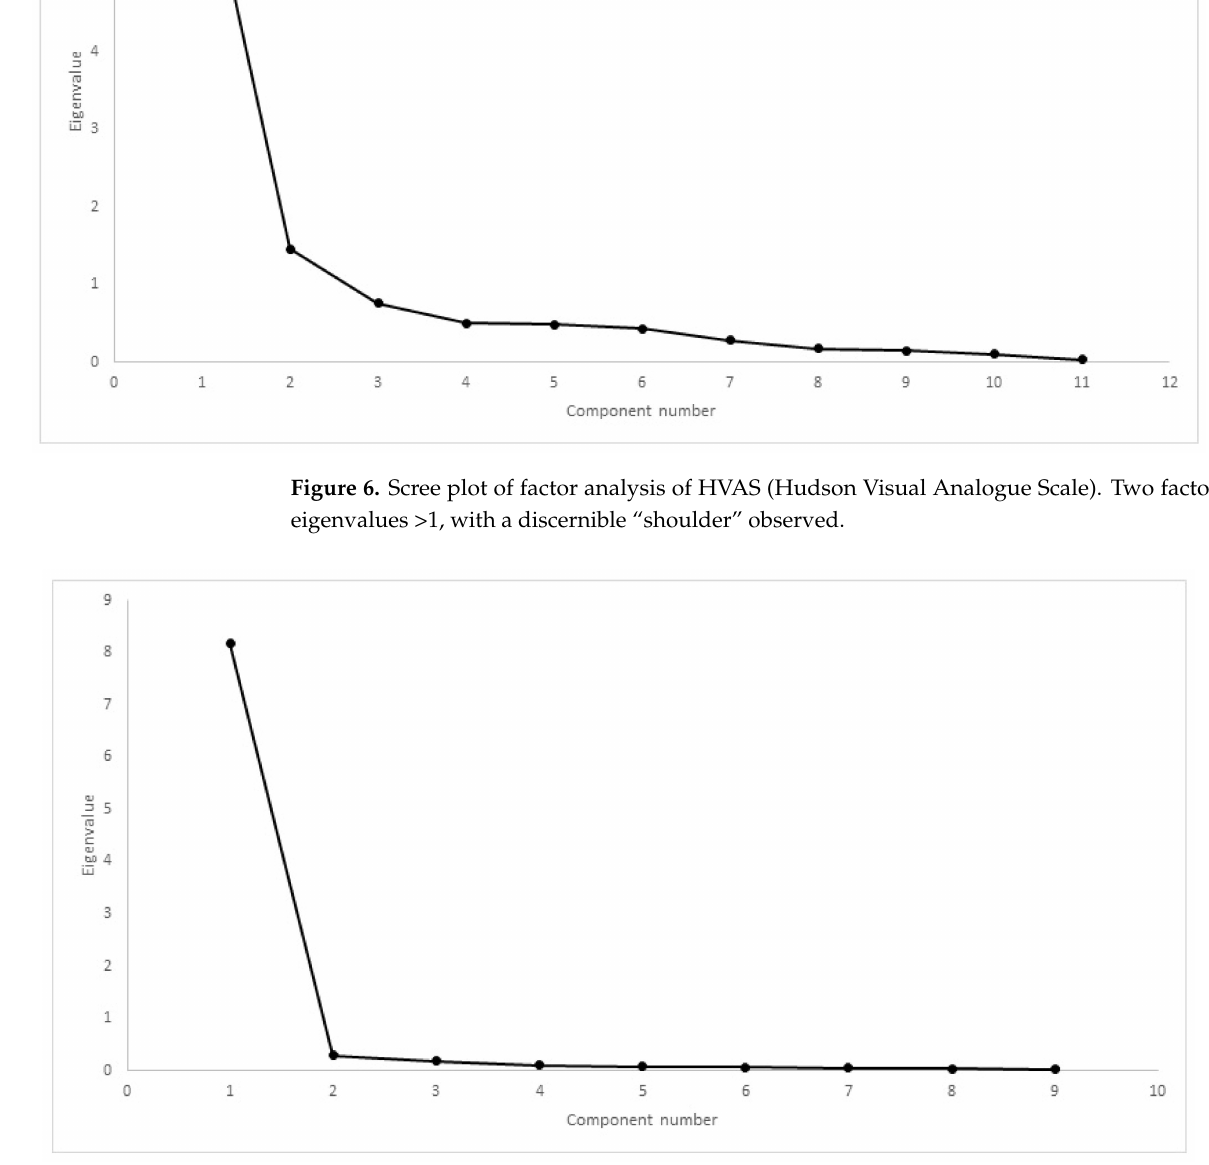
Figure 7. Scree plot of factor analysis of CBPI. One factor had eigenvalue >1, with a discernible “shoulder”